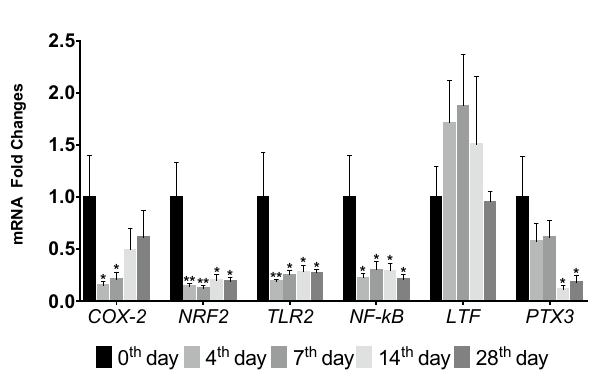
Figure 2. Expression levels of FASN (Fatty Acid Synthase), SCD (Stearoyl-CoA Desaturase), and ACACA (Acetyl-CoA Carboxylase Alpha) genes in milk somatic cells (Mean ± SEM); *: P < 0.05, Fold change differences in 4th, 7th, 14th and 28th days were compared to 0th day.